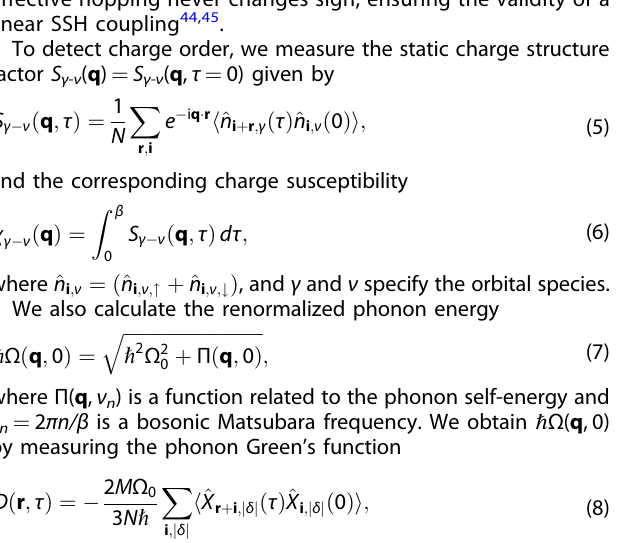
χ 6s − 6s ( q ) versus q for various